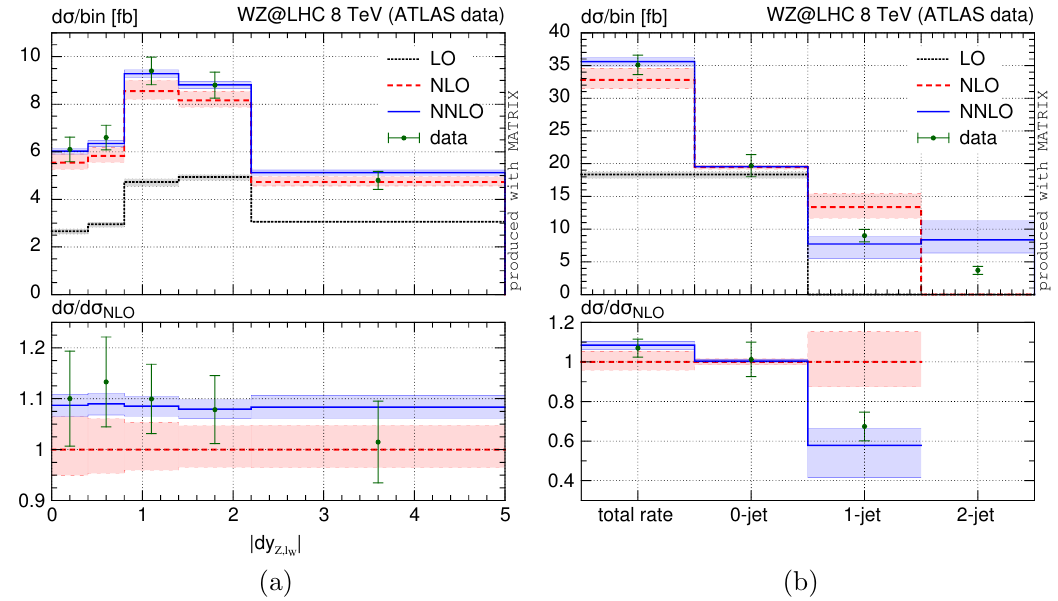
Figure 6 . Same as (cid:12)gure 3, but for (a) the absolute rapidity separation between the reconstructed Z boson and the lepton from the W -boson decay, and (b) the number of jets. it extends up to roughly 2 (cid:27) 3 (cid:27) for the lowest and highest p miss (cid:0)